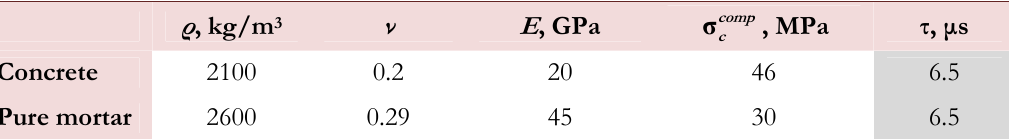
Table 1: Parameters of concrete and mortar.